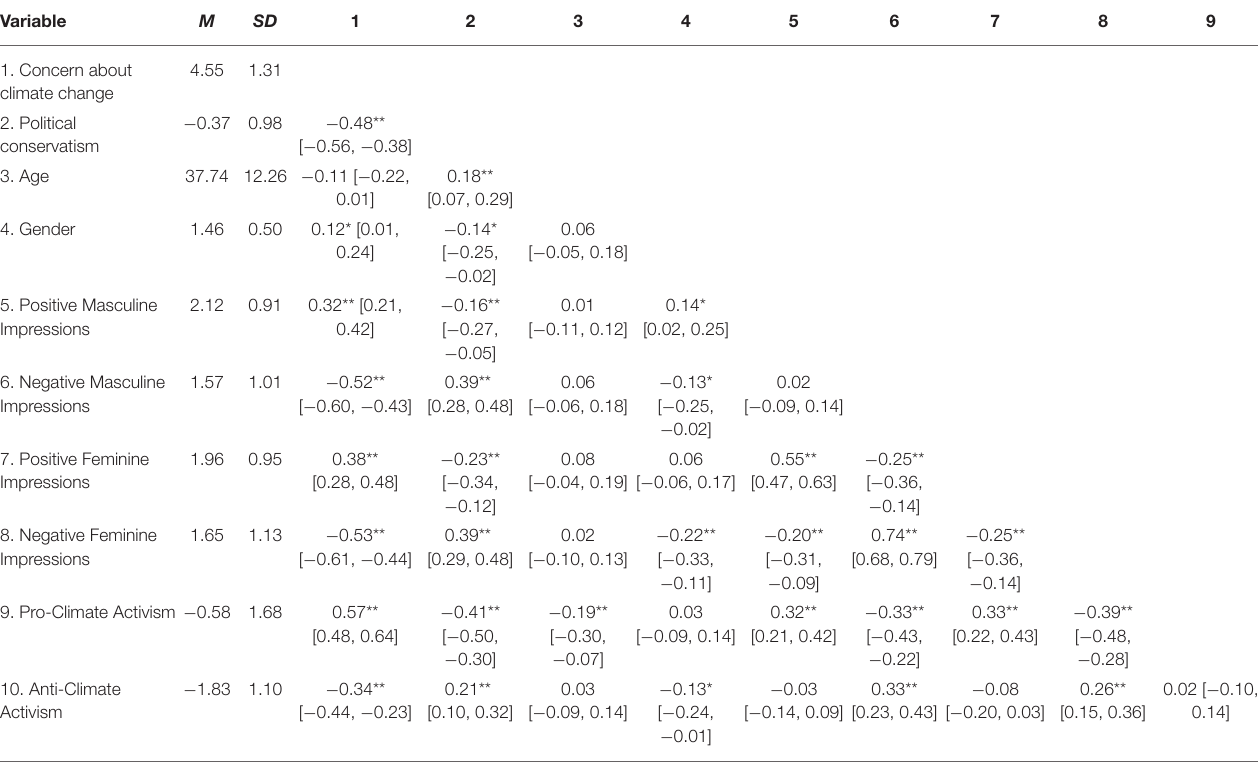
TABLE 1 | Means, standard deviations, and correlations with confidence intervals for measures used in Study 1.